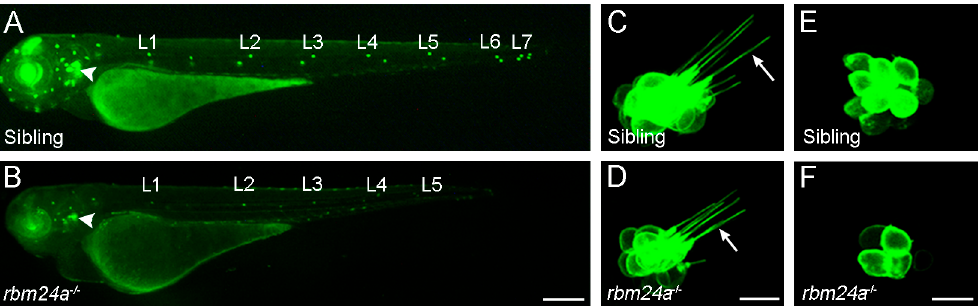
Figure 3. Defective hair cell morphogenesis in zebrafish rbm24a mutants. Hair cells in the otic vesicle and lateral line neuromasts are labeled through expression of the Tg( pou4f3:GAP-GFP ) transgene. Adapated with permission from ref. [17]; published by Elsevier, 2020. Stereo-fluorescence images were acquired at 3 dpf (days post-fertilization) for whole embryos and hair cells. ( A , B ) Formation of the otic vesicle (arrowheads) and neuromasts (L1–L7) in wild-type embryos and rbm24a mutants. Scale bar: 250 µ m. ( C , D ) Loss of Rbm24a impairs hair cell morphogenesis, resulting in reduced cristae size and short hair cell kinocilia (arrows). Scale bar: 10 µ m. ( E , F ) High magnification shows defective development and organization of L1 neuromast hair cells in rbm24a mutants. Scale bar: 10 µ